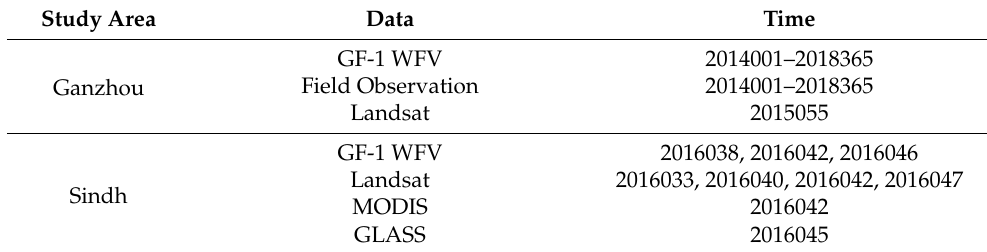
Table 3. Validation